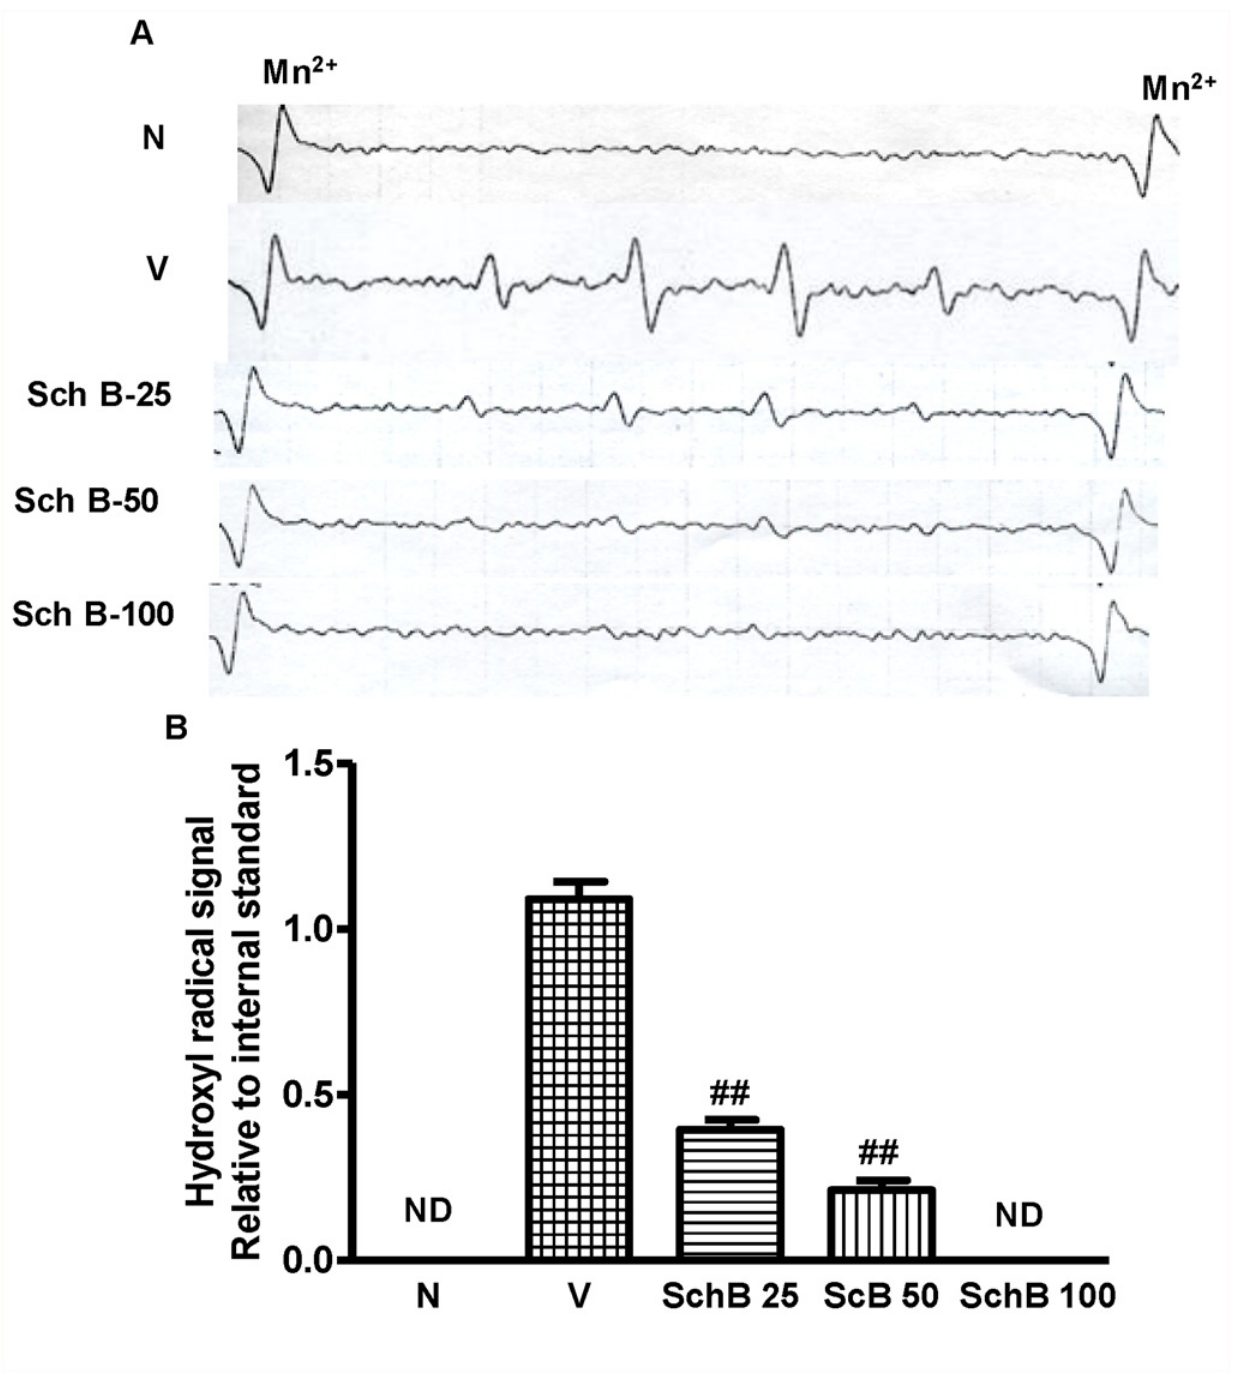
Fig 6. Sch B attenuates Dox-induced hydroxyl radical. (A, B) Representative ESR spectra and analysis of the hydroxyl radical signal relative to the internal standard of manganese ion. Hydroxyl radical signals were not detected (ND) in hearts of group N and group Sch B-100. Mn (3) and Mn (4) indicate the internal standard signals of manganese ion (Mn 2+